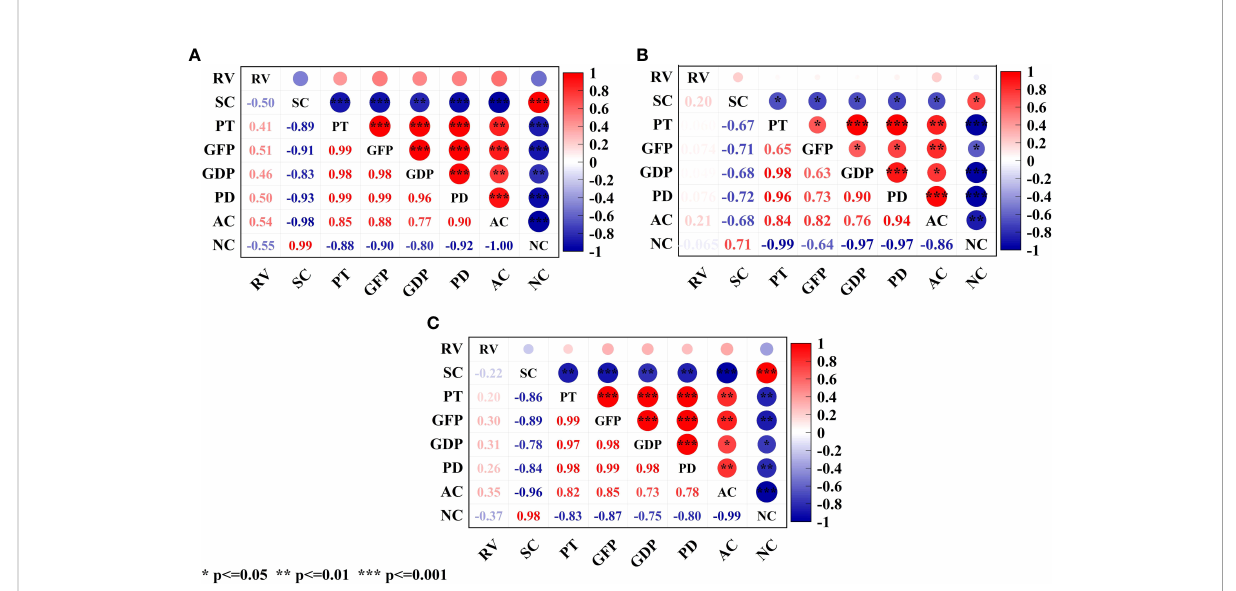
FIGURE 9 Correlation of coastline variations with various factors in: (A) the whole Pearl River Estuary (PRE), (B) east coast in the PRE, and (C) west coast in the